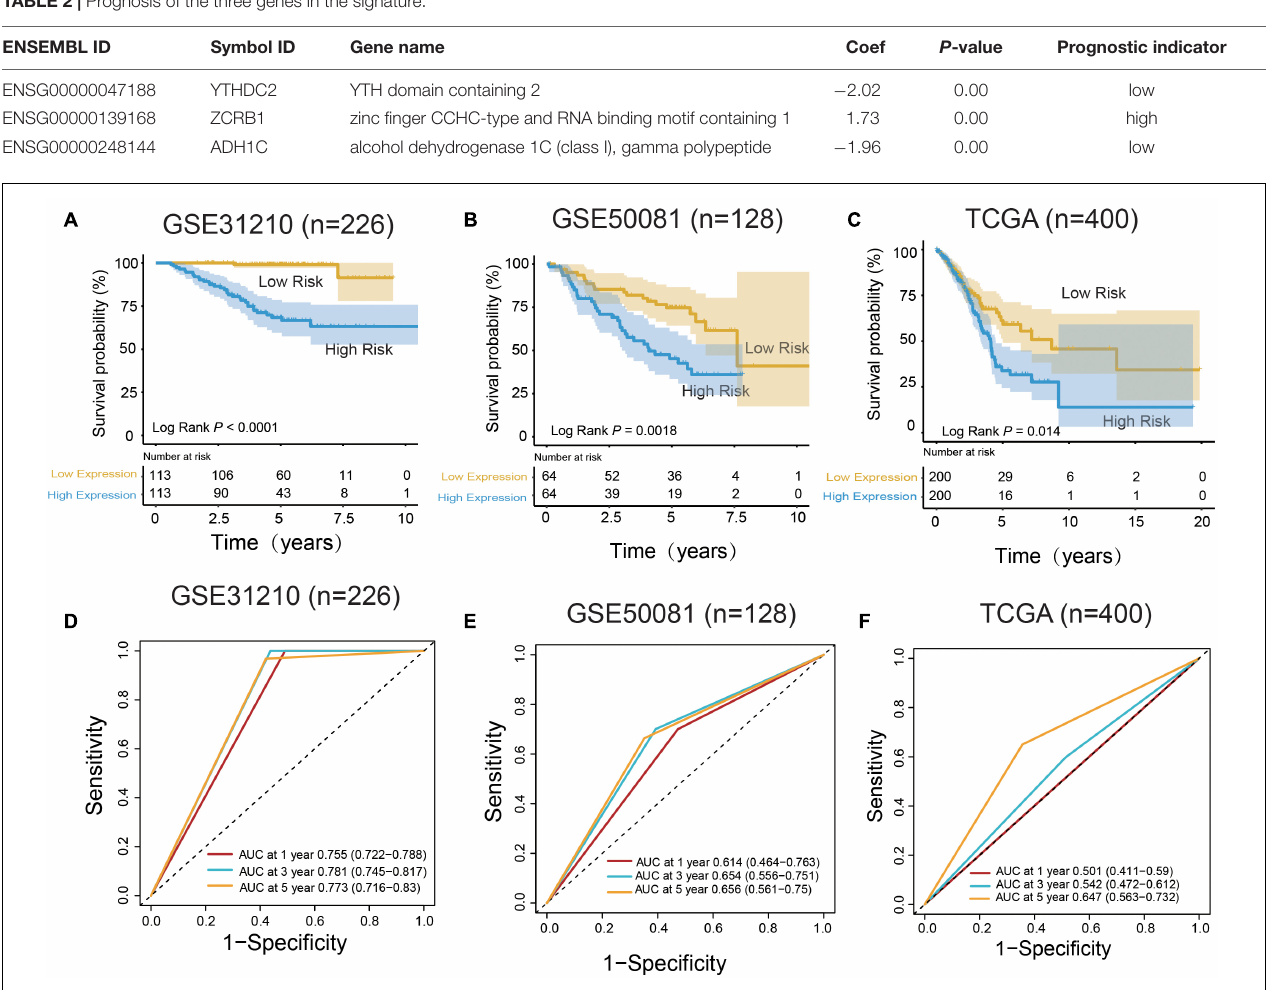
FIGURE 3 | m 6 A RNA methylation regulators and m 6 A-related genes signature predict overall survival of patients of LUAD. (A–C) Kaplan–Meier survival curves classify patients into high- and low-risk groups by the m 6 A RNA methylation regulators and m 6 A-related genes signature in the training dataset (GSE31210), and test dataset (GSE50081 and TCGA). P values were calculated by log-rank test. (D–F) m 6 A RNA methylation regulators and m 6 A-related genes signatures were used for predicting survival in 1, 3, and 5 years by TimeROC analysis.